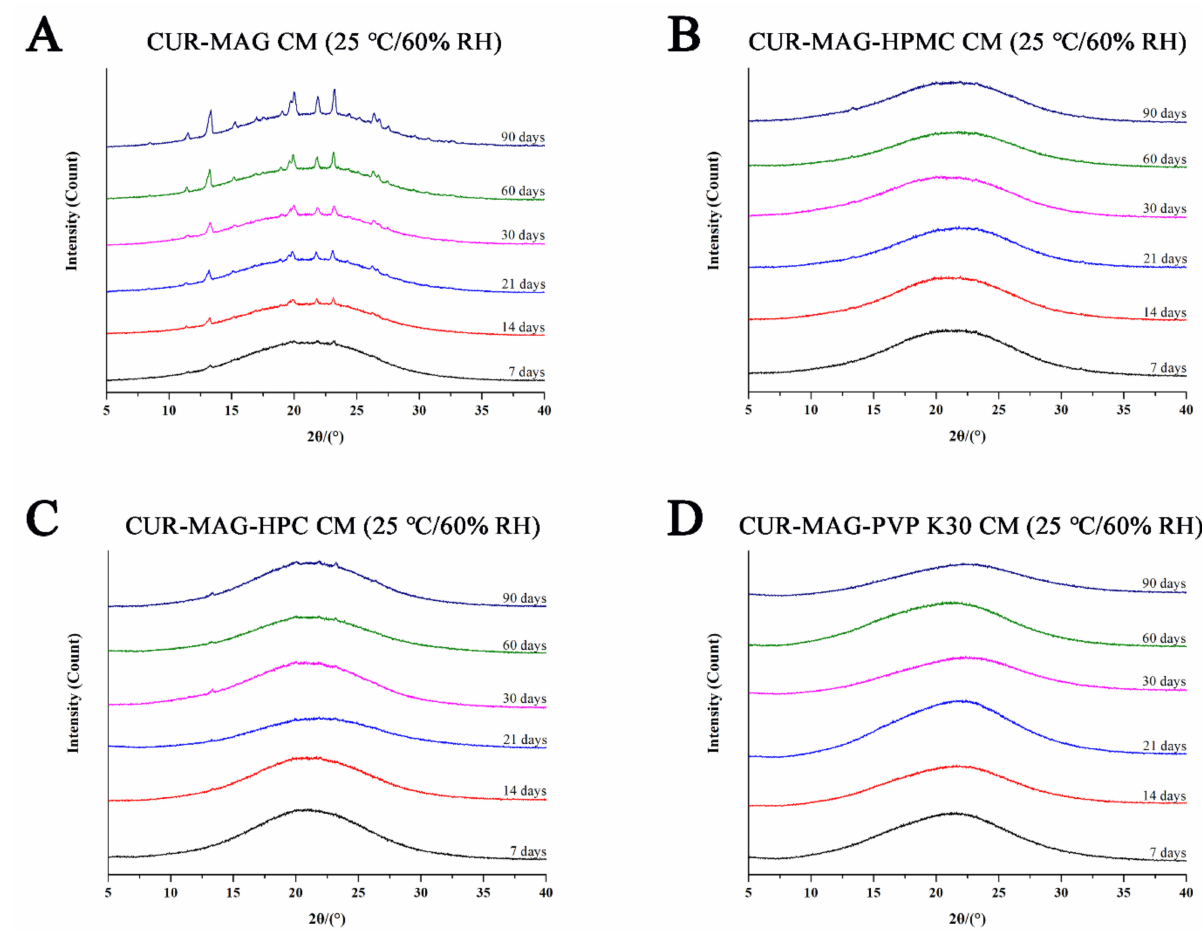
Figure 12. XRPD diffractograms: ( A ) CUR-MAG CM; ( B ) CUR-MAG-HPMC CM; ( C ) CUR-MAG-HPC CM; ( D ) CUR-MAG- PVP K30 CM stored at 25 ◦ C/60% RH condition for different